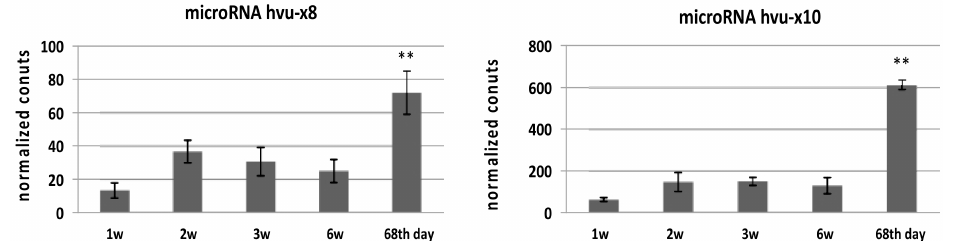
Figure 4. Normalized counts for novel miRNAs from sRNA libraries prepared from five barley developmental stages. Y-axis represents normalized counts from sRNA libraries and x-axis presents level of particular miRNA in barley developmental stages. Name for each novel miRNA is provided above each graph. All novel miRNAs are most abundant in the 68 d of development. Statistical significance is provided on each graph (** p -value ≤ 0.01).